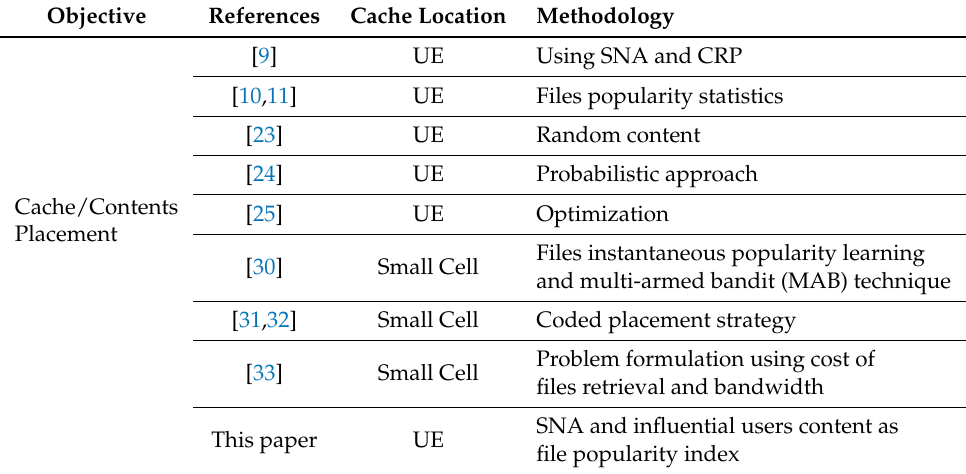
Table 1. Different caching techniques and their